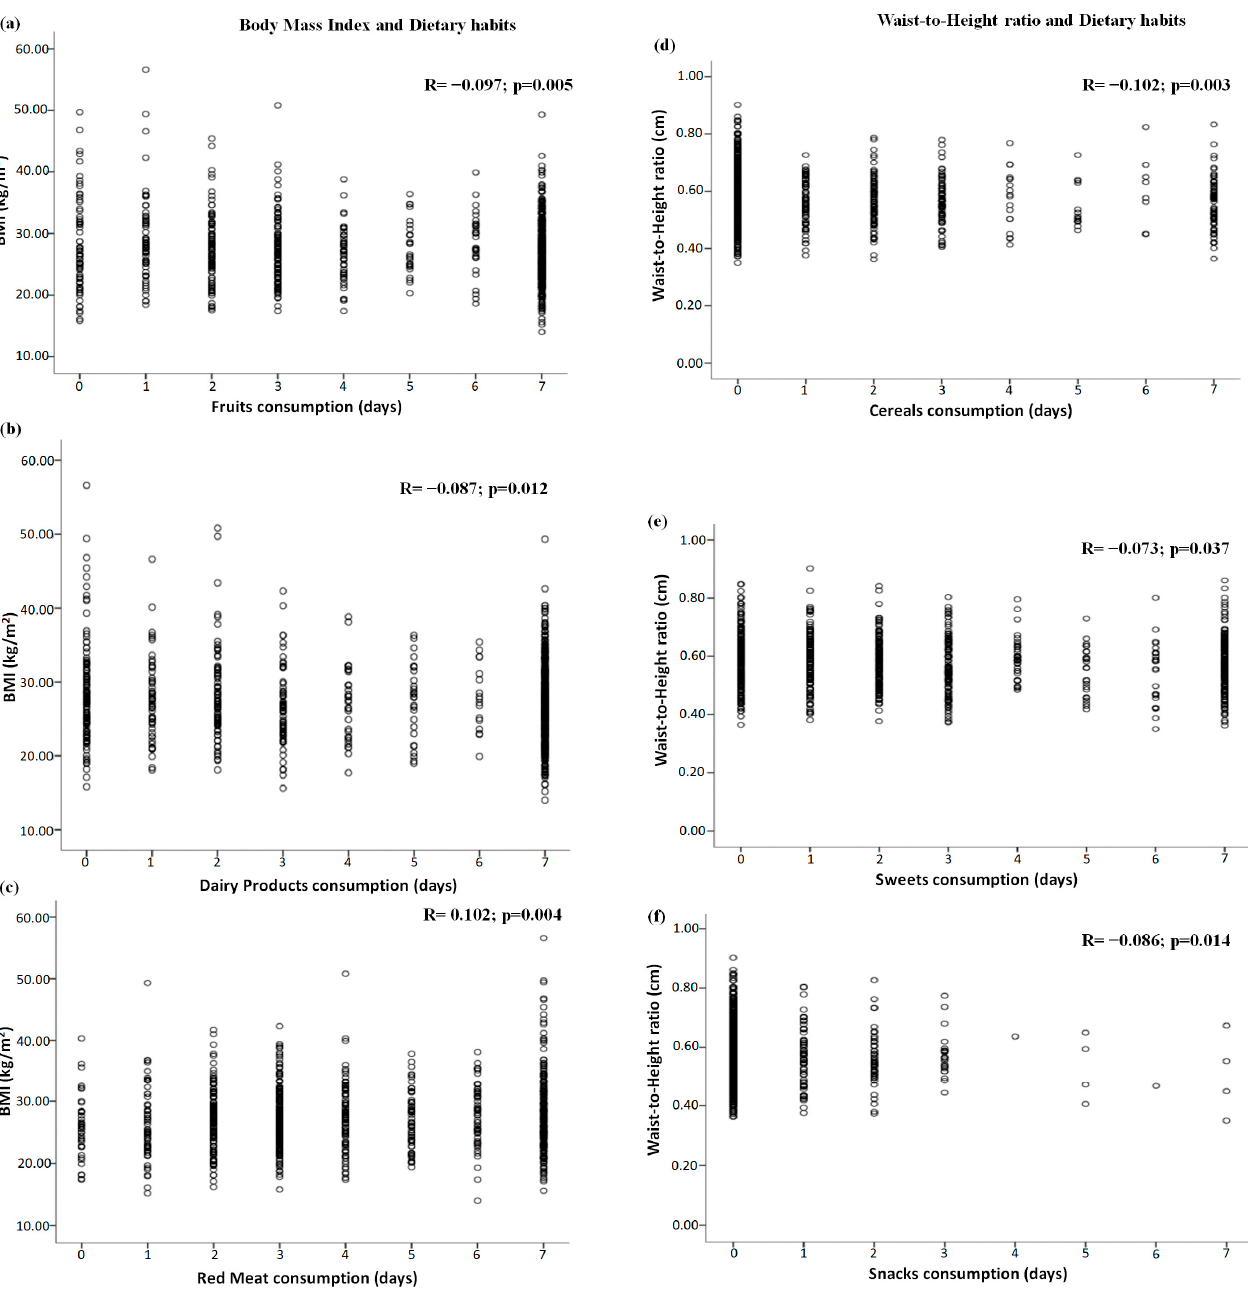
Figure 1. Significant correlations between dietary habits and global and central adiposity: ( a – c ) cor- relations between global adiposity (i.e., body mass index) and fruit, dairy product, and red meat consumption, respectively, and ( d – f ) correlations between central adiposity (i.e., waist-to-height ratio) and cereal, sweet, and snack consumption, respectively. Note: BMI = body mass index.